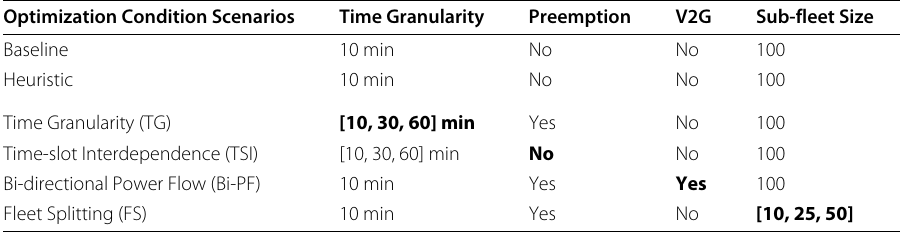
Optimization Condition